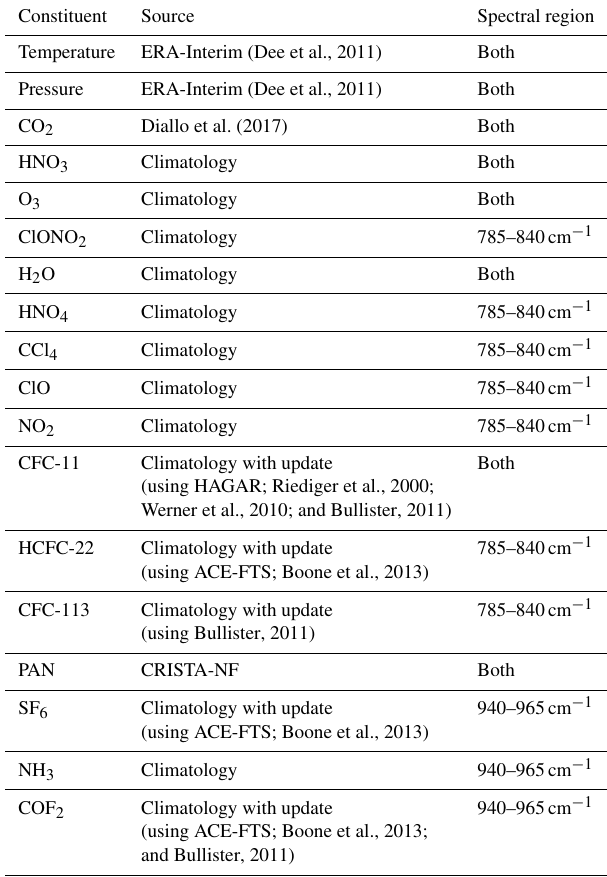
Table 2. Set-up of the background atmosphere for the simulations.